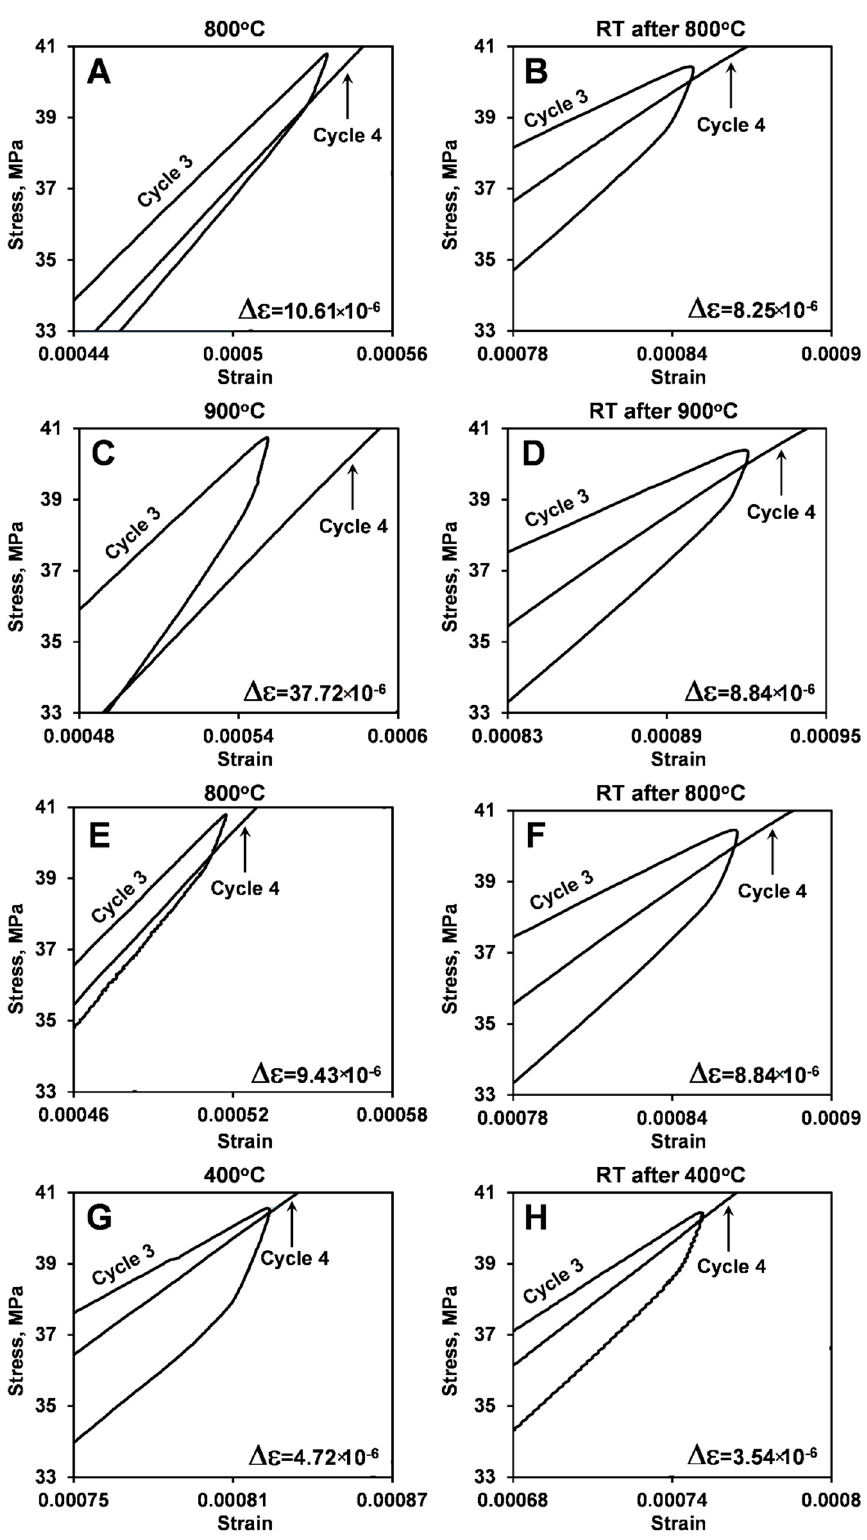
Figure 7. Portions of cycle 3 loading/unloading and cycle 4 loading stress-strain deformation plots of LaCoO 3 sample #2 showing the presence of creep strain shift Δ ε at testing performed at different temperatures: ( A ) 800 °C; ( B ) RT after 800 °C; ( C ) 900 °C; ( D ) RT after 900 °C; ( E ) 800 °C; ( F ) RT after 800 °C; ( G ) 400 °C; ( H ) RT after 400 °C. The corresponding values of Δε are shown in Table 3.